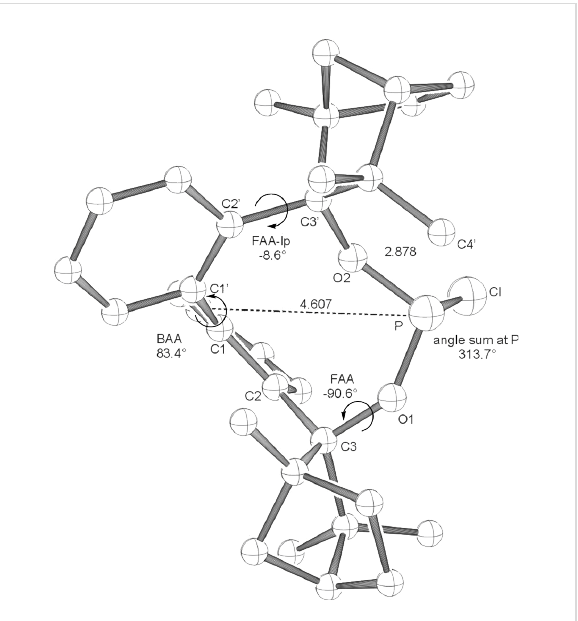
Figure 9: Computed geometry (PM3) of plus -( P )- BIFOP-Cl with unnat- ural plus -( P )-biaryl conformation. Distances are given in Å. (BAA = biaryl angle between C 2 -C 1 -C 1 '-C 2 '; FAA-lp = fenchyl-aryl dihedral angle between C 1 -C 2 -C 3 -O 1 ; FAA = fenchyl-aryl dihedral angle between C 1 '-C 2 '-C 3 '-O 2 ).